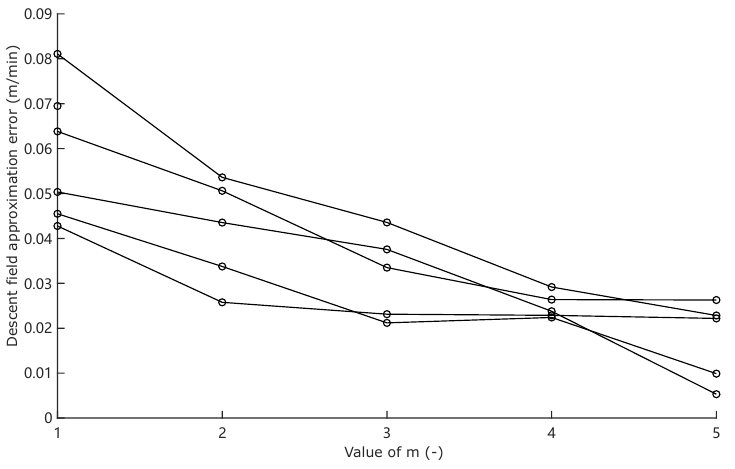
Figure 8. The relationship between m and the approximation